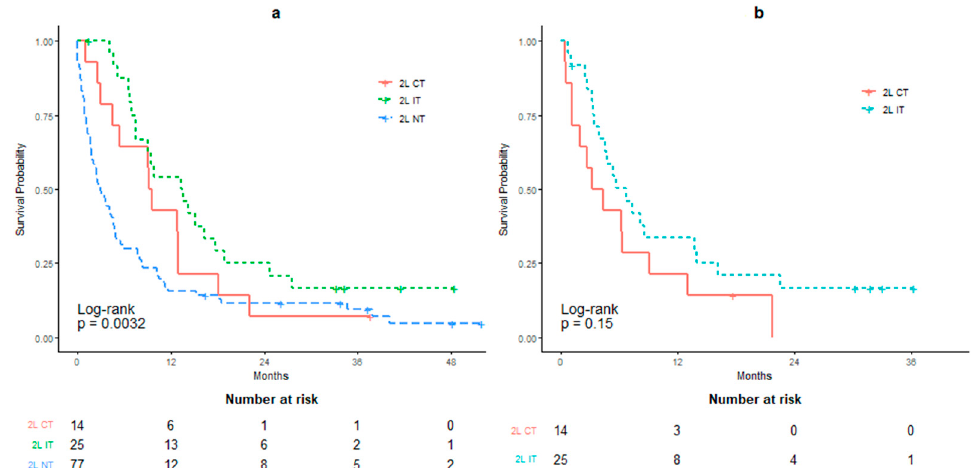
Figure 5. Overall survival (OS) in patients receiving second-line palliative therapies. ( a ) OS calcu- lated from termination of first-line therapy. ( b ) OS calculated from initiation of second-line ther- apy. Therapies include chemotherapy (2L CT), immunotherapy (2L IT) or no treatment (2L NT).